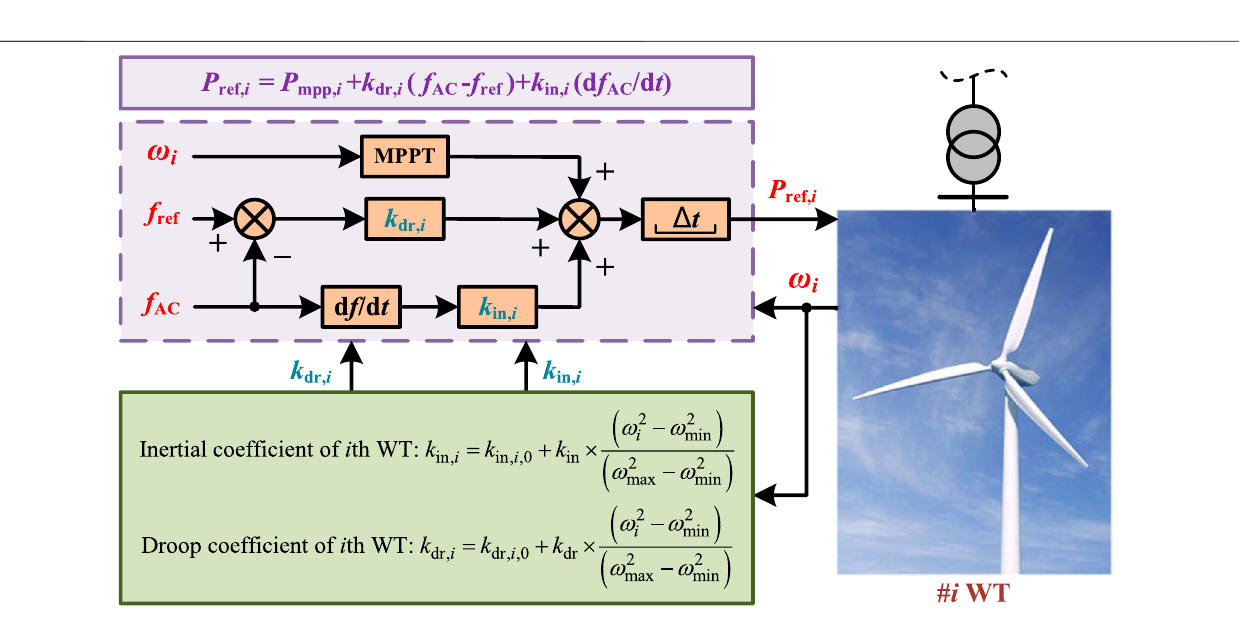
Frontiers in Energy Research |